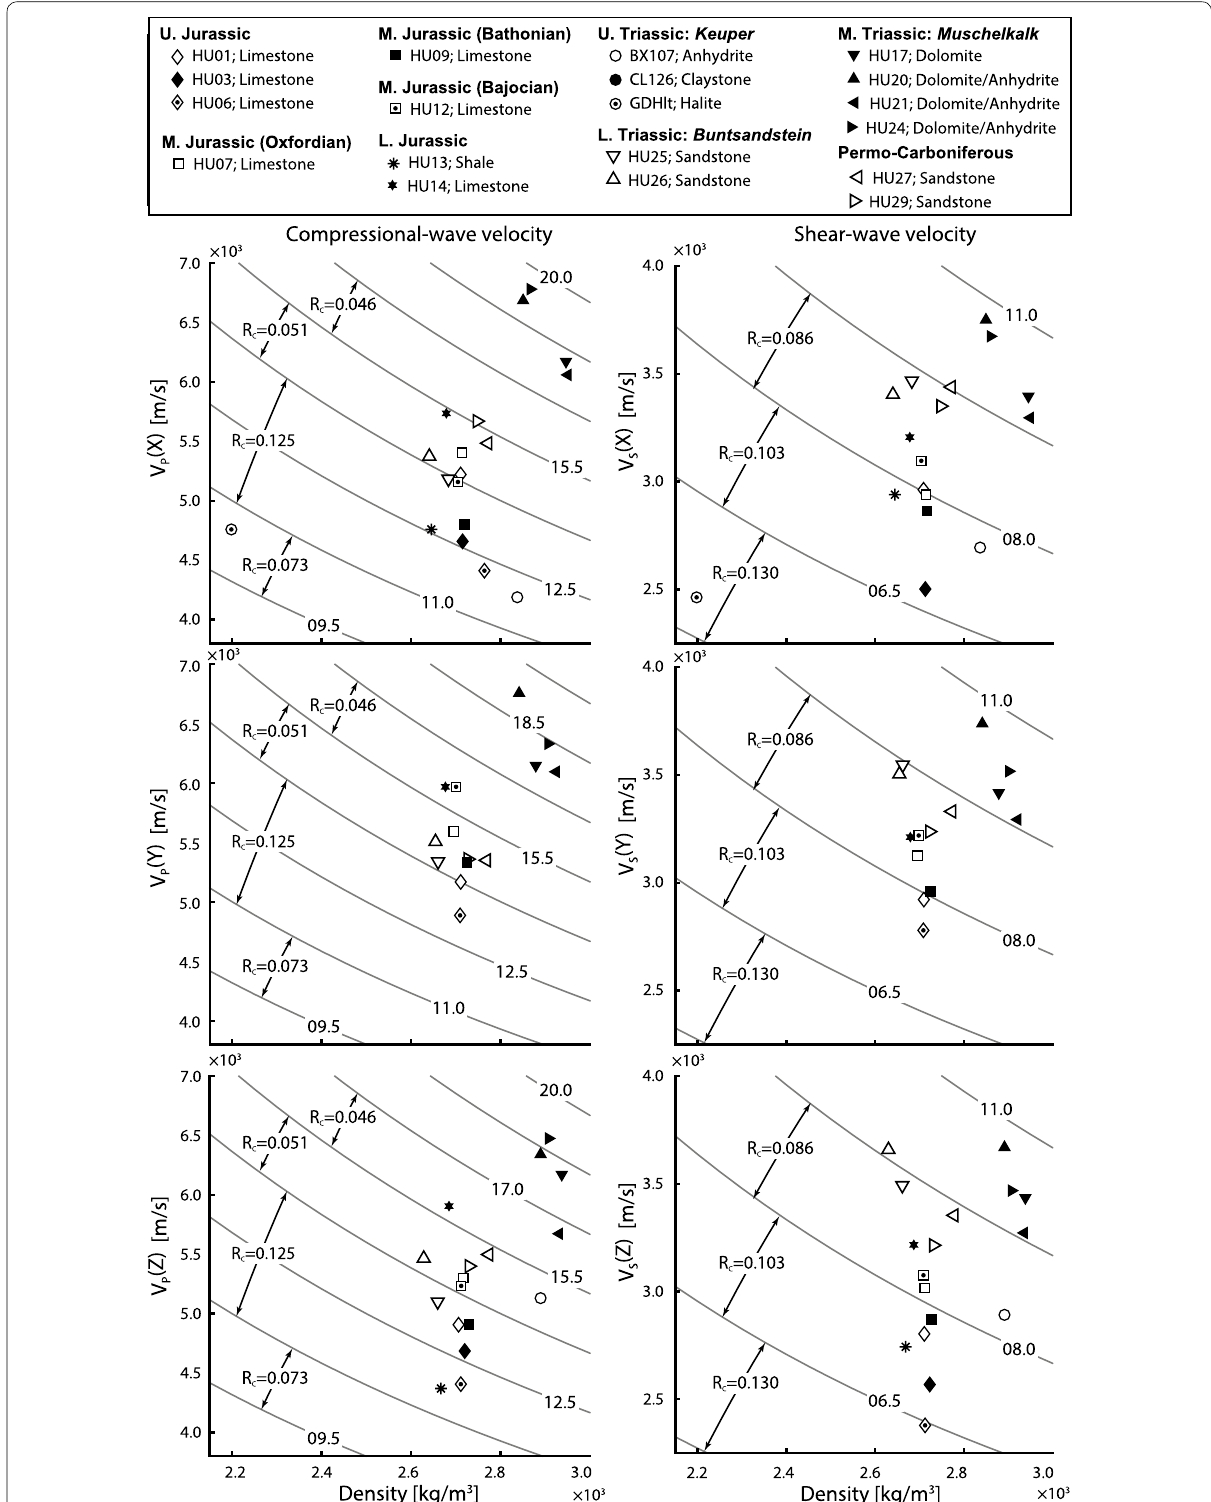
Fig. 15 Grain density versus the compressional and shear seismic velocity with lines of constant acoustic impedance. Reflection coefficients values are reported between the acoustic impedance contours. All seismic velocities have been calculated at borehole conditions. Error bars are within